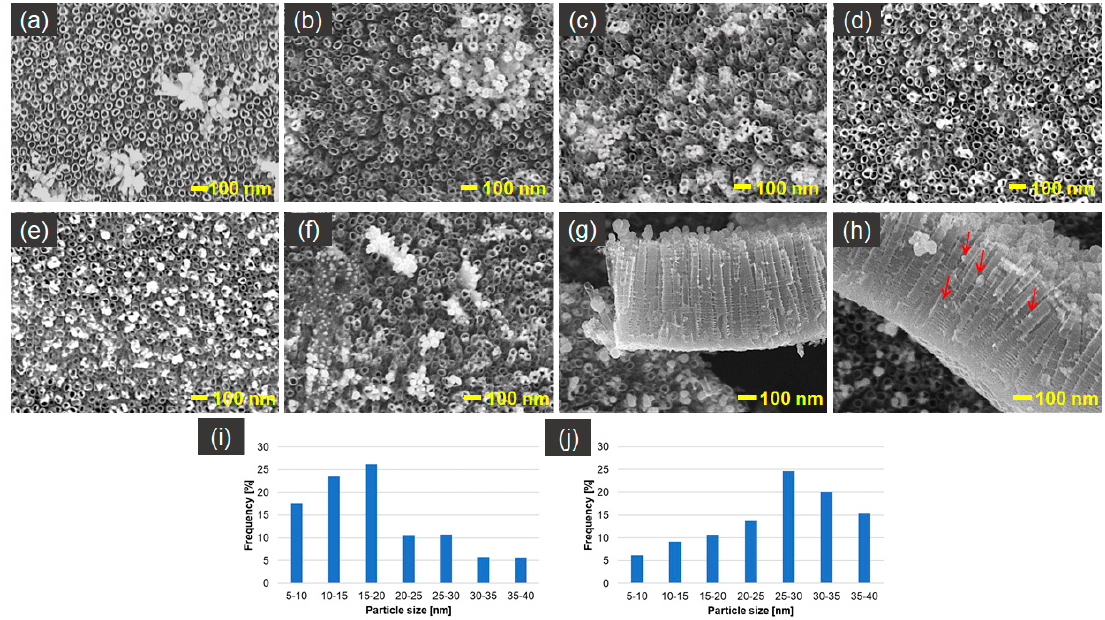
Figure 2. SEM top-view images of AgNPs / TNT platforms prepared by voltammetric method by: ( a ) 5, ( b ) 10, ( c ) 15, ( d ) 20, ( e ) 25, ( f ) 30 cycles, ( g , h ) crss-sectional images of 25 cycles_AgNPs / TNT and histograms of particle-size distribution for: ( i ) 20 cycles_AgNPs / TNT, ( j ) 25 cycles_AgNPs / TNT. Table 2. The values of OCP and size of AgNPs deposited on TNT platforms prepared by voltammetric method.